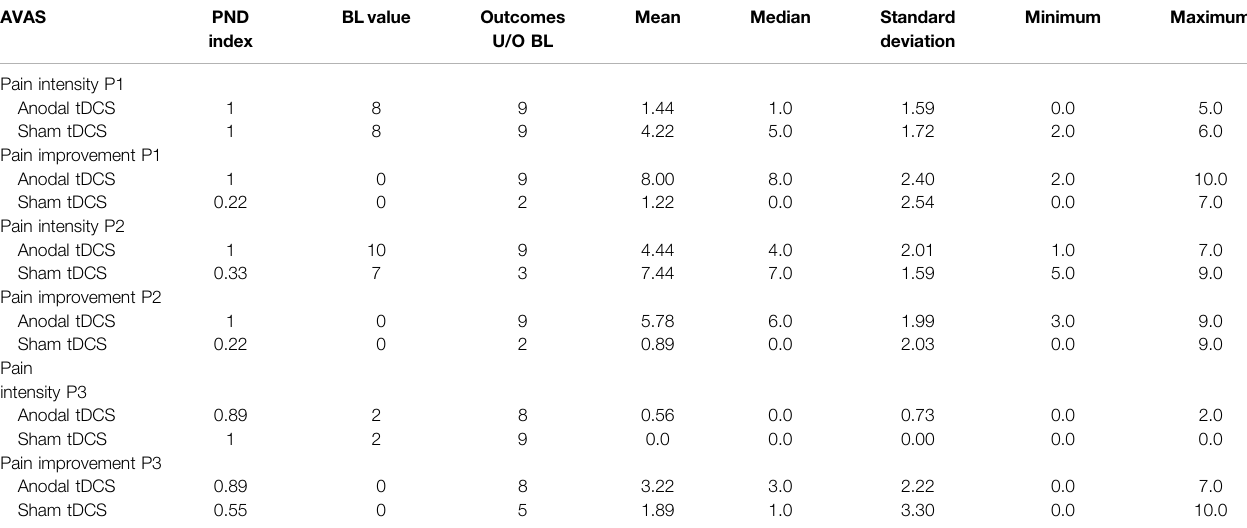
TABLE 2 | Results of the percentage of nonoverlapping data (PND) index for the pain intensity and pain improvement AVAS values regarding the anodal and sham overall data of each patient. AVAS PND